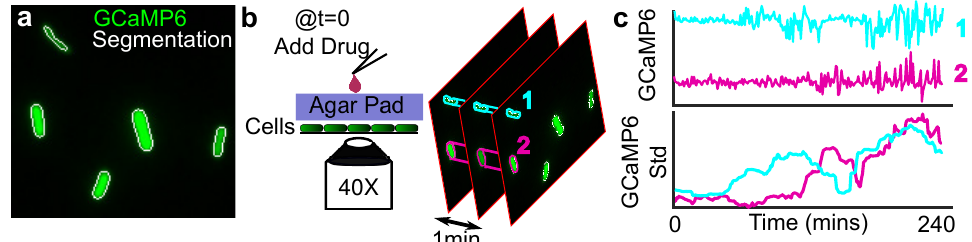
Figure 1. Measuring Ca 2 + dynamics in single E. coli. ( a ) BW25113 cells are labeled with a GCaMP6f- mScarlet dual fusion plasmid (mScarlet channel not shown). Cells are segmented (white outline) using both channels (see Methods Image Processing ). ( b ) Dilute cells in log-phase growth are affixed to a 2% agarose pad and inverted into a 96-well plate for imaging. Drug addition is done at t = 0 by pipetting on top of the agarose. Cells are imaged at 1-minute intervals. ( c ) The Ca 2 + dynamics are extracted from the single-cell segmentation (top panel). Rapid oscillations in the cellular Ca 2 + content, so-termed Ca 2 + transients, have previously been observed in response to aminoglycosides [35]. To quantify these oscillations, a moving window standard deviation (std, bottom panel) is calculated. As the magnitude of the Ca 2 + transients increases in a given time- window, the std increases. The sliding window size is 30